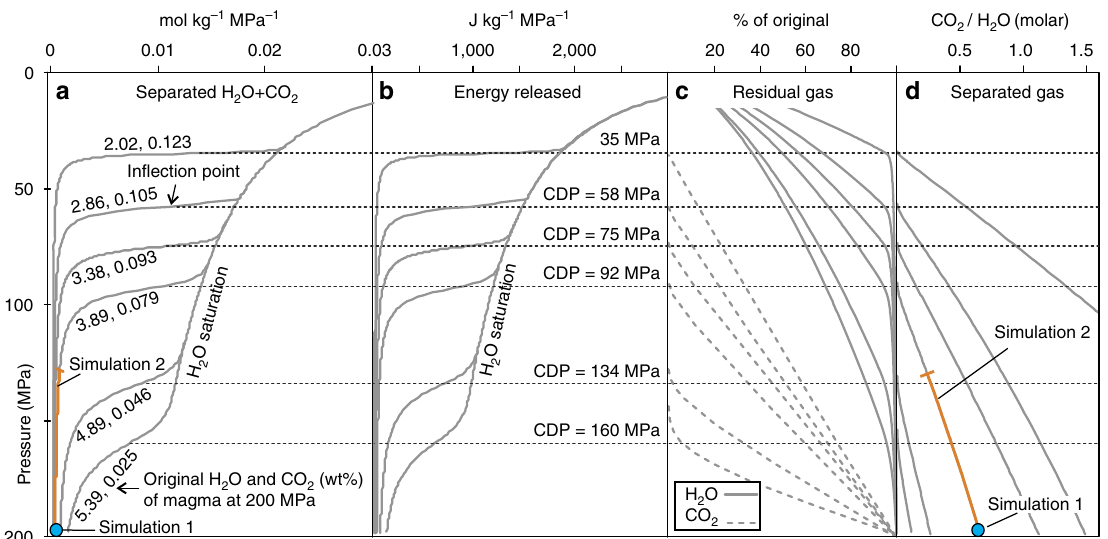
Figure 1 | Open-system magma-degassing models for CFc. The different curves refer to different initial H 2 O and CO 2 contents and describe the evolution of the fluids released during magma depressurization in an open-system Rayleigh-type degassing process (where at each infinitesimal decompression step, an infinitesimal parcel of gas phase in excess of the permissible saturation is distilled from the well-mixed magma). Theoretical degassing curves were calculated for the most-primitive magma compositions of CFc (trachybasalt) and show the pressure dependence of ( a ) the moles of H 2 O and CO 2 released by one kilogram of magma for each 1-MPa decrease in pressure; ( b ) the energy associated with fluid release (enthalpy of the separated H 2 O–CO 2 mixture at the specific temperature and pressure, computed using MUFITS 63 ); ( c ) the residual gas in the melt, as a percentage of the original content; and ( d ) the CO 2 /H 2 O ratio of the released fluids. The blue circle and orange line indicate the conditions used in the corresponding TOUGH2 (ref. 26)